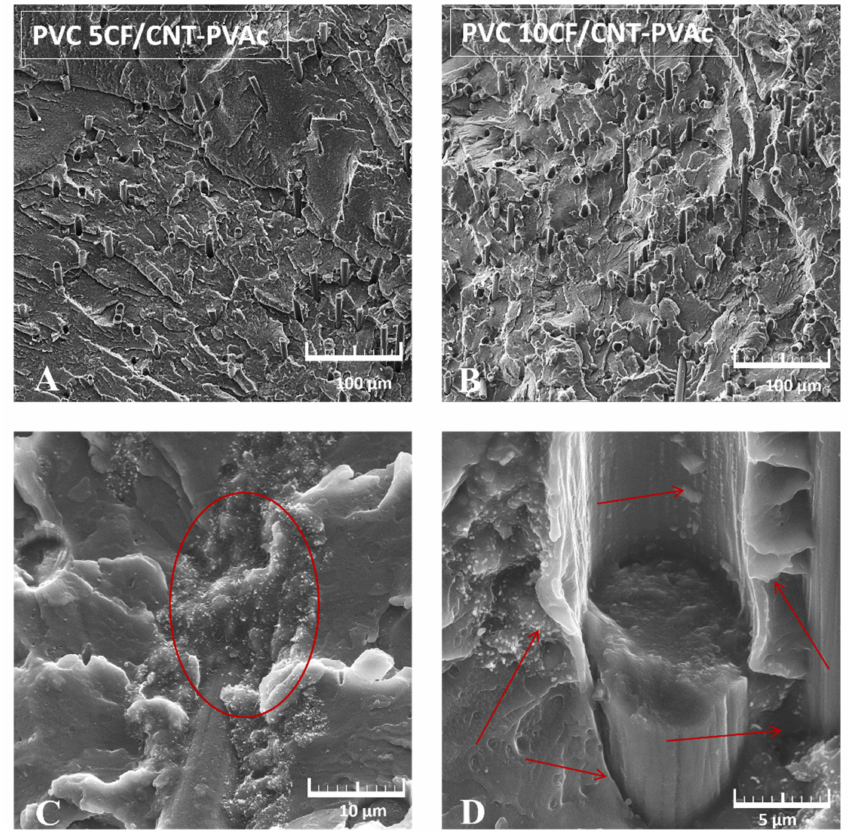
Figure 9. SEM observations of cryogenic fracture of PVC hybrid filler composites. ( A ) PVC 5CF/CNT- PVAc - mag. 500 × ( B ) PVC 10CF/CNT-PVAc - mag. 500 × ( C ) fibre–matrix interface - mag. 5 k × ( D ) fibre–matrix interface mag. 10 k ×